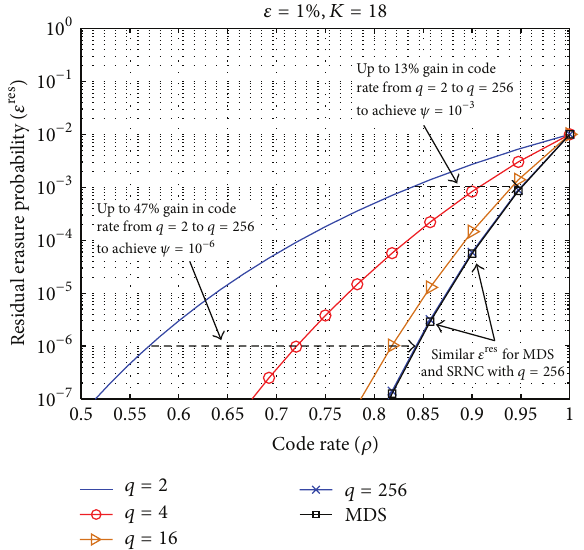
Figure 4: Effect of the field size on residual erasure